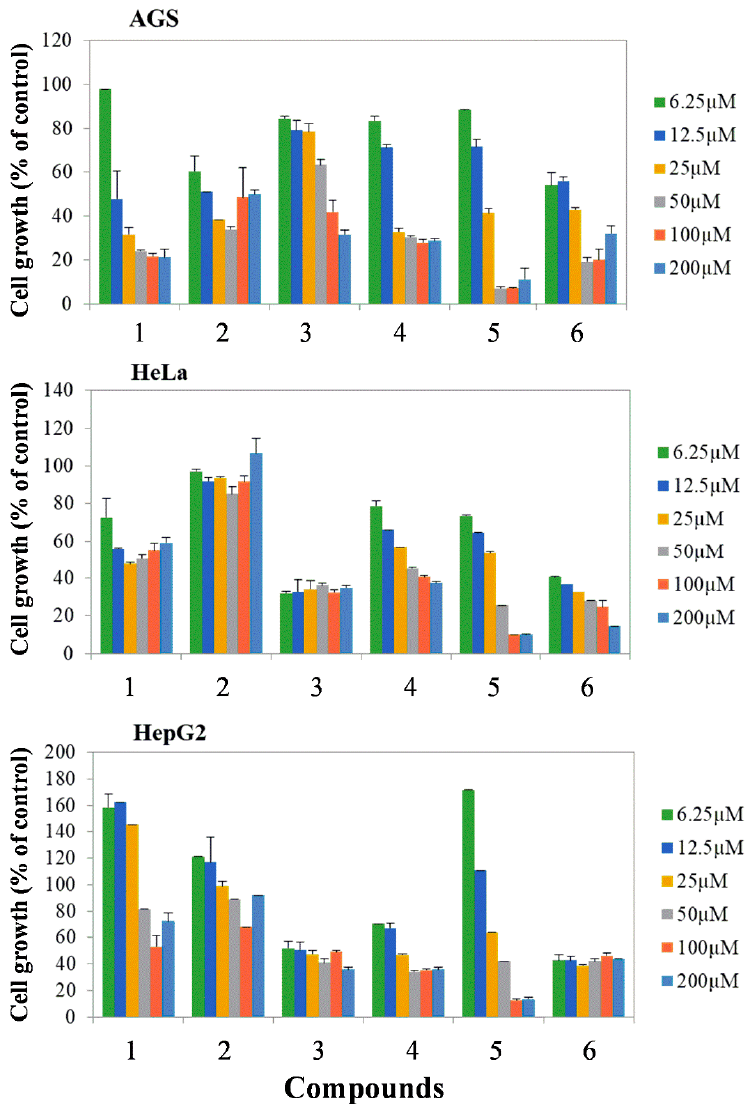
Figure 5. Inhibitory effects of anthraquinones and their derivatives on cancer cell AGS (gastric cancer cell), HeLa (cervical cancer cell), and HepG2 (Liver cancer cell) growth. (1) Anthraflavic acid; (2) Alizarin; (3) 2-amino-3-hydroxyanthraquinone; (4) Anthraflavic acid- O -glucoside; (5) Alizarin- O -glucoside; (6) 2-amino-3- O -glucoxyanthraquinone.